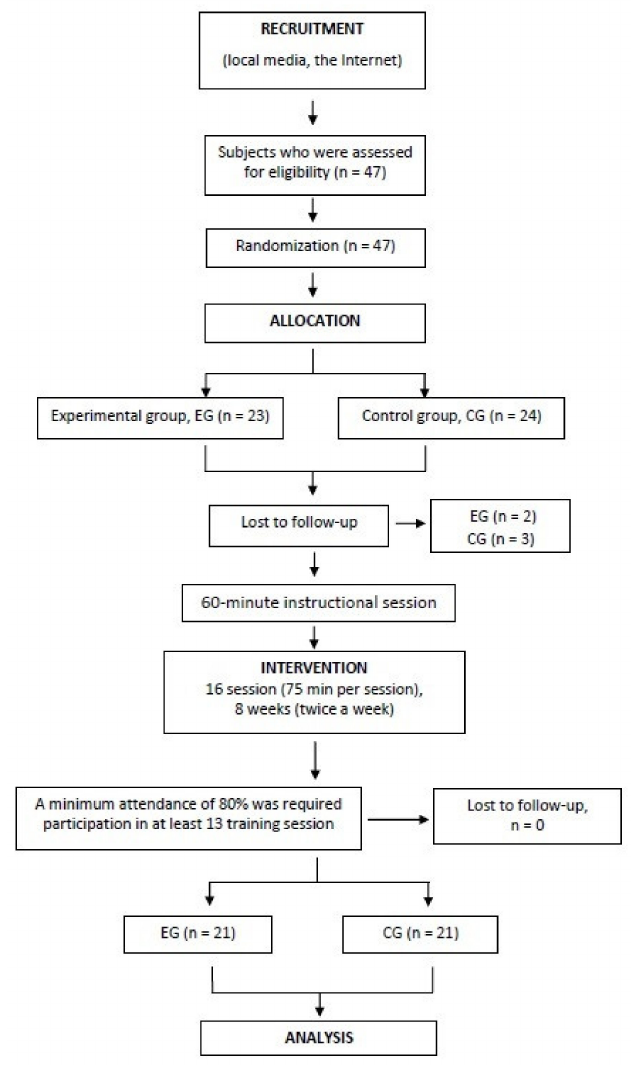
Figure 1. Flowchart of the study